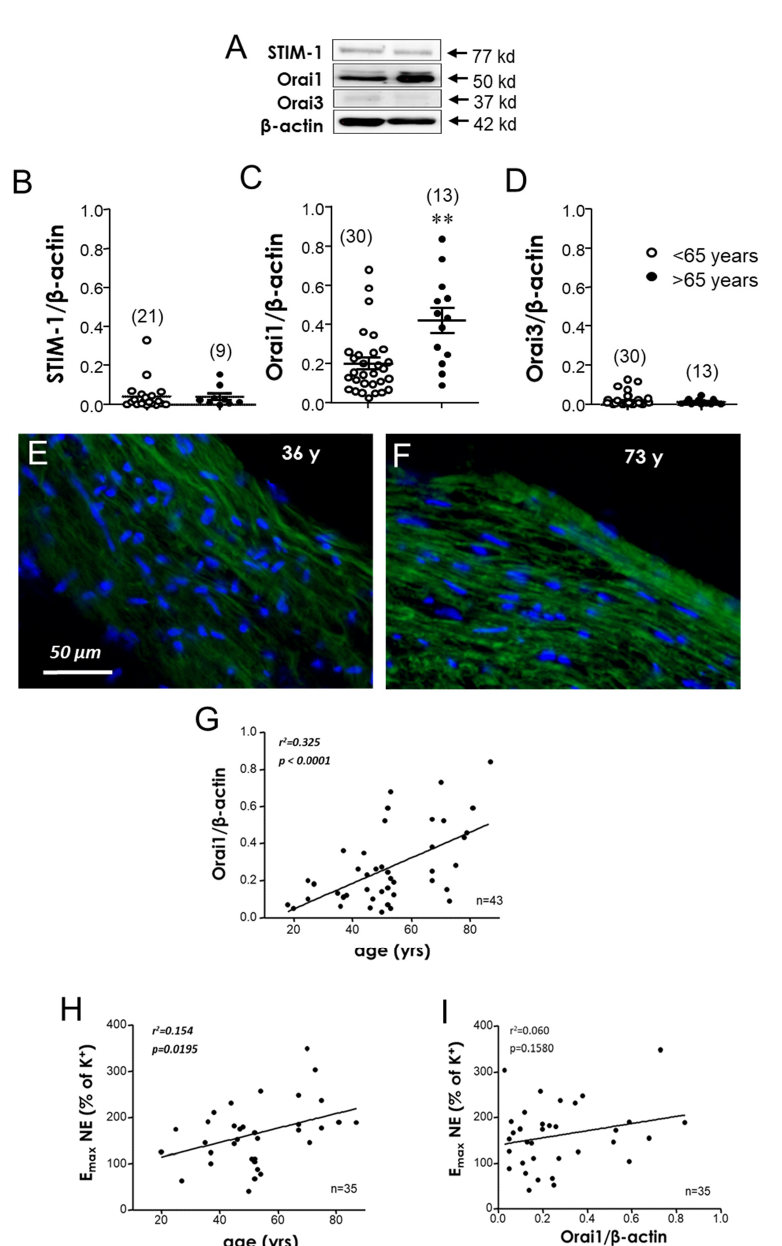
Figure 2 . Aging is associated with an overexpression of the Orai1 channel in human aortic strips. ( A ) Representative immunoblots for the detection of STIM-1, Orai1, and Orai3 and corresponding β -actin in aortic strip homogenates from subjects <65-years and >65-years old. Quantification of expression assays for STIM-1, Orai1, and Orai3 are displayed in panels B , C , and D , respectively. Data are expressed as mean ± SEM of band intensities normalized by respective β -actin band intensities. n indicates the number of subjects. ** p < 0.01 vs. <65-year-old group by unpaired t -test. ( E , F ) Representative immunofluorescence images for the detection of Orai1 (green fluorescence) in cryosections of aortic strips from a 36 year-old subject and a 73 year-old subject, respectively. Nuclei are counterstained in blue. Magnifications: × 200. ( G ) Simple regression analysis of individual values of the Orai1 expression in human aortic strip homogenates with respect to the age of the subject from which the tissue was obtained. ( H ) The association between adrenergic contraction determined as the maximum response (E max ) to norepinephrine (NE) expressed as the percentage of K + -induced contraction with respect to the age from the same subject. ( I ) Association between aortic Orai1 quantification and E max to NE. Every point represents the averaged E max value of the strips from one single subject. Coefficients of determination (r 2 ) and p values are indicated for each association (in bold italic when